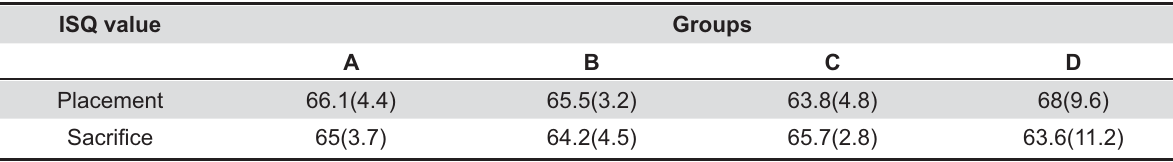
Table 1- Implant stability quotient values [Mean(SD)] measured by resonance frequency analysis at the time of implant